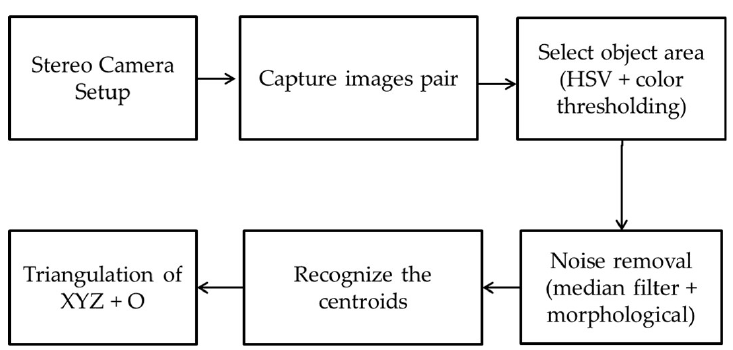
Figure 17. The sequence of processes in estimating the position of XYZ + O.